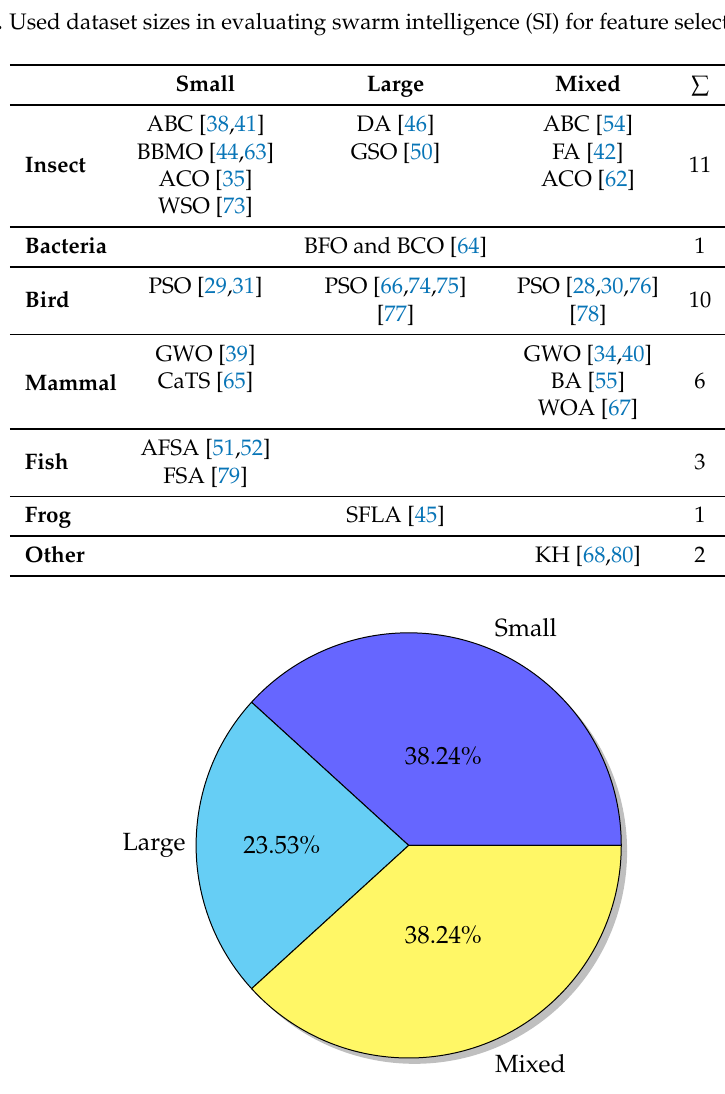
Figure 7. Analysis of used datasets in swarm intelligence